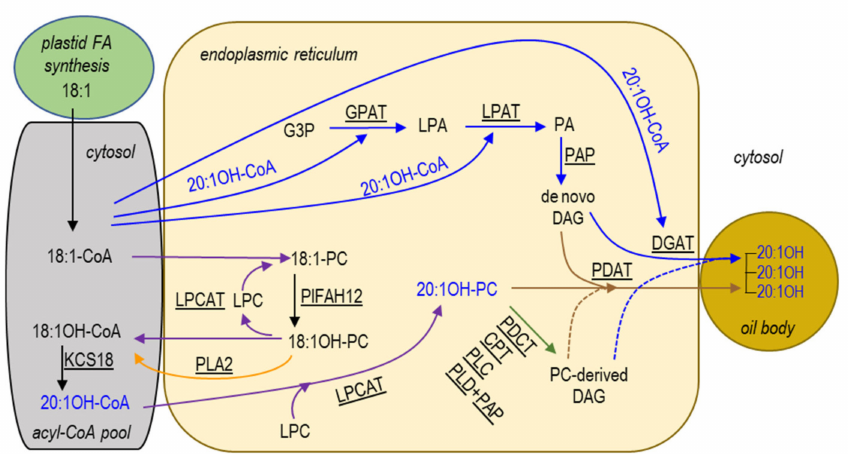
Figure 1. Proposed pathways for triacylglycerol (TAG) biosynthesis in P. lindheimeri seed. Blue arrows indicate reactions involved in Kennedy pathway. Purple arrows indicate reactions involved in acyl editing by LPCAT. Brown arrows indicate PDAT-mediated pathways. Green arrows indicate reactions involved in PC-derived DAG synthesis. Dotted lines indicate PC-derived DAG utilized by DGAT and PDAT. Enzymes catalyzing these reactions are underlined. FA numerical